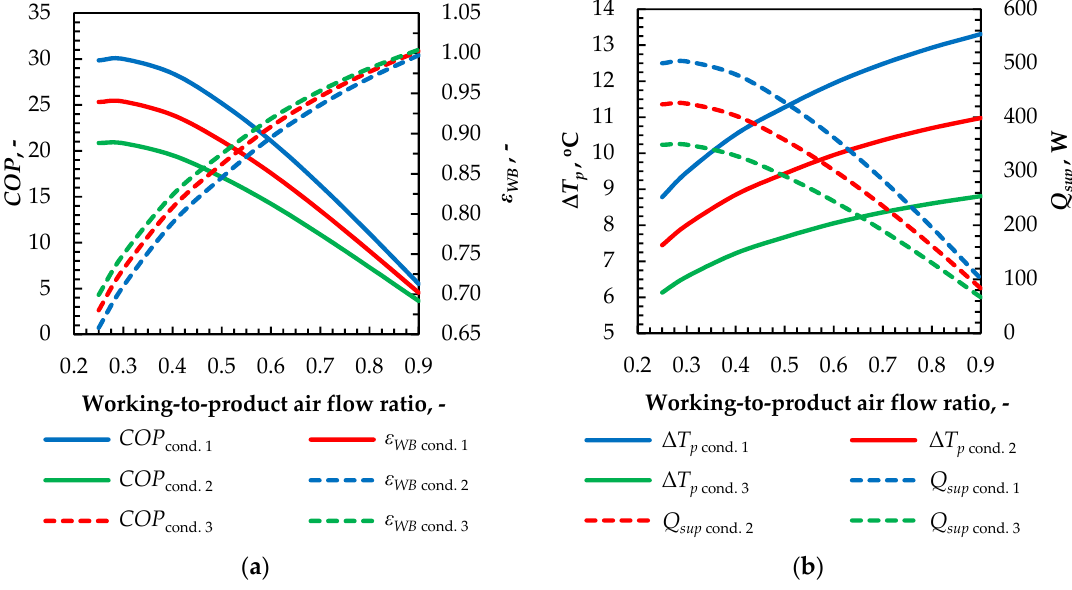
Figure 12. Impact of working-to-product airflow ratio: ( a ) COP coefficient and wet bulb effectiveness; ( b ) Product air temperature difference and supply cooling capacity.